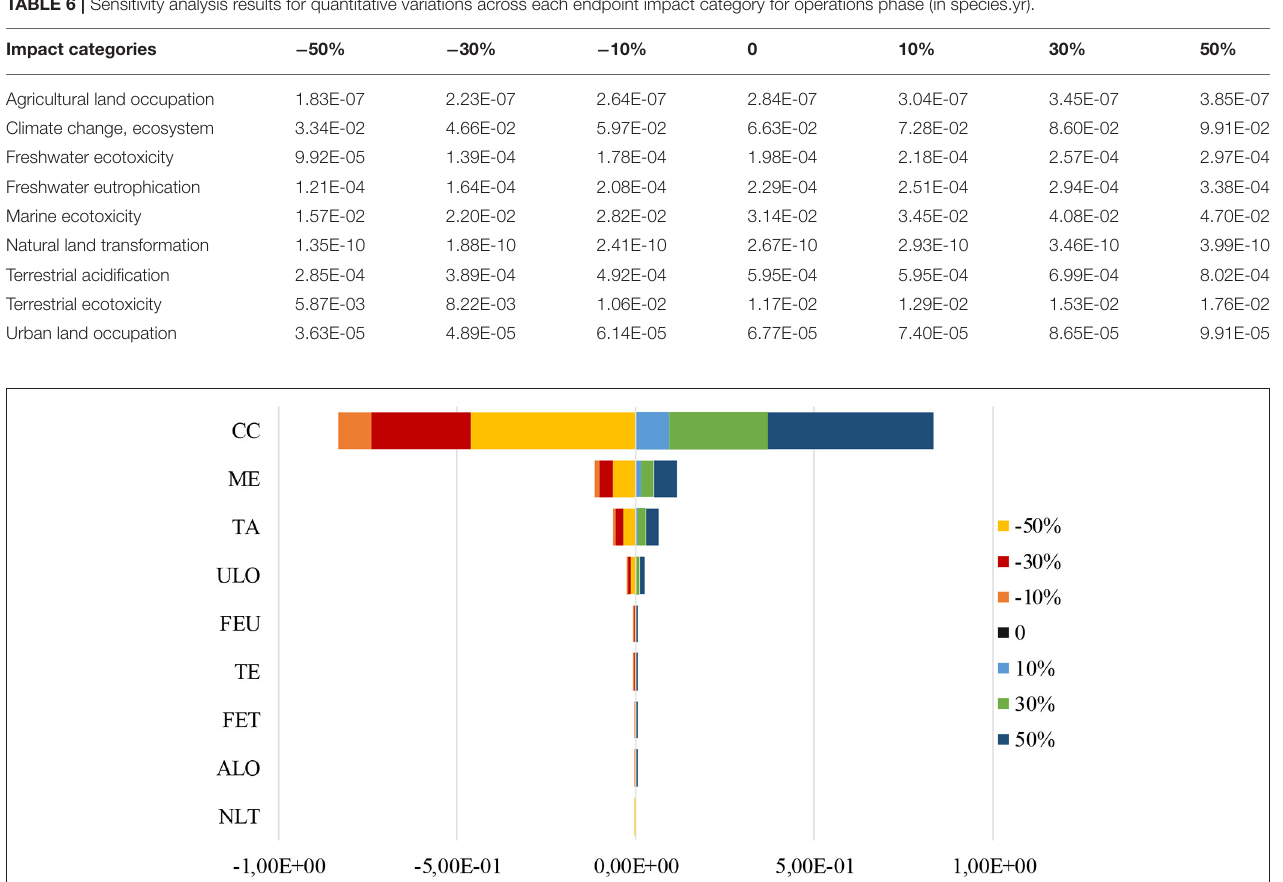
TABLE 6 | Sensitivity analysis results for quantitative variations across each endpoint impact category for operations phase (in species.yr).